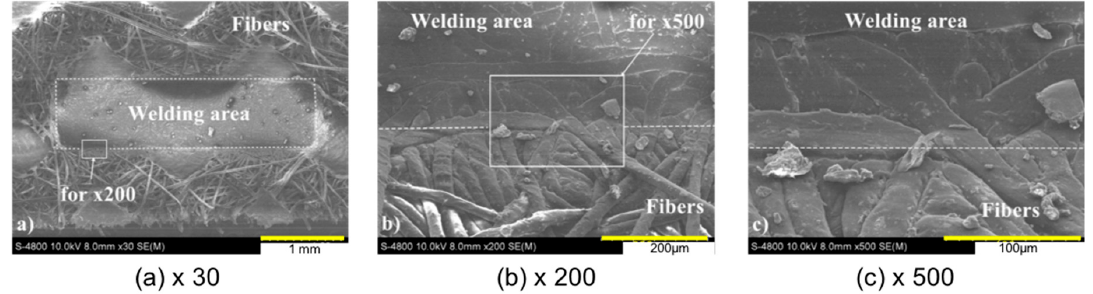
front with magnification of ( a ) ×30, ( b ) ×200, and ( c ) ×500.